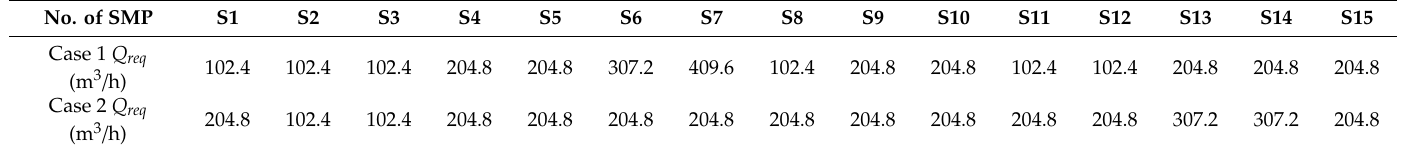
Table 1. Required discharges ( Q req ) of the submain pipes.